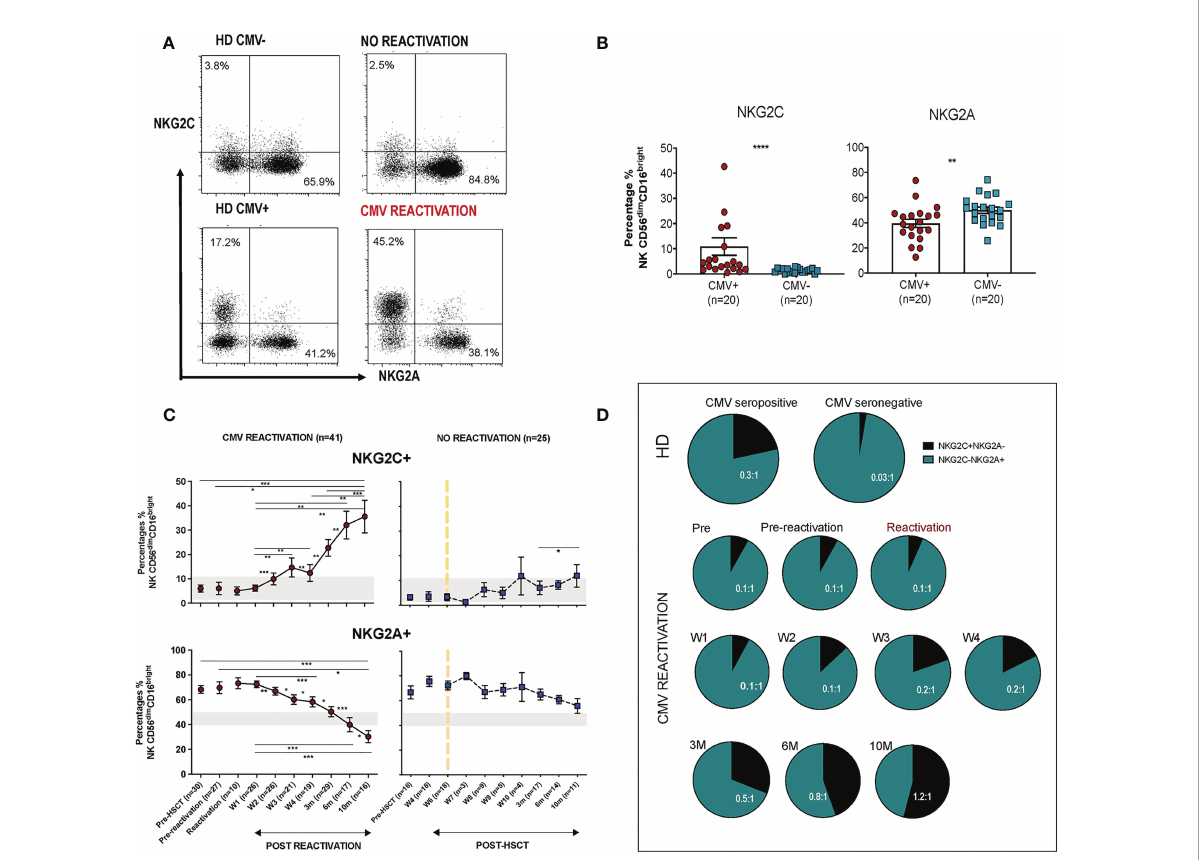
FIGURE 2 Rapid and long term expansion of the NKG2C+ NK cell subset following CMV reactivation in patients after allo-HSCT. (A) Gating examples to show NKG2C/NKG2A expression on CD56 dim CD16 bright NK subsets in CMV seropositive or seronegative healthy donors (HD) and allo-HSCT patients following CMV reactivation or no-reactivation. (B) Percentage of NKG2C+ and NKG2A+ NK cells within the CD56 dim CD16 bright subset in CMV seronegative and seropositive HDs. (**p<0.01, ****p<0.0001; Mann Whitney test). (C) Percentage of NKG2C+ (Top) and NKG2A+ (bottom) NK cells from CD56 dim CD16 bright population in patients following reactivation (left) and without reactivation patients (right). Grey lines represent the range of NKG2C+ and NKG2A+ NK cells in HDs. (*p<0.05, **p<0.01, ***p<0.001; Wilcoxon sign rank test for matched time points). (D) Ratio of NKG2C+ and NKG2A+ cells within CD56 dim CD16 bright population in HSCT patients with CMV reactivation and in healthy